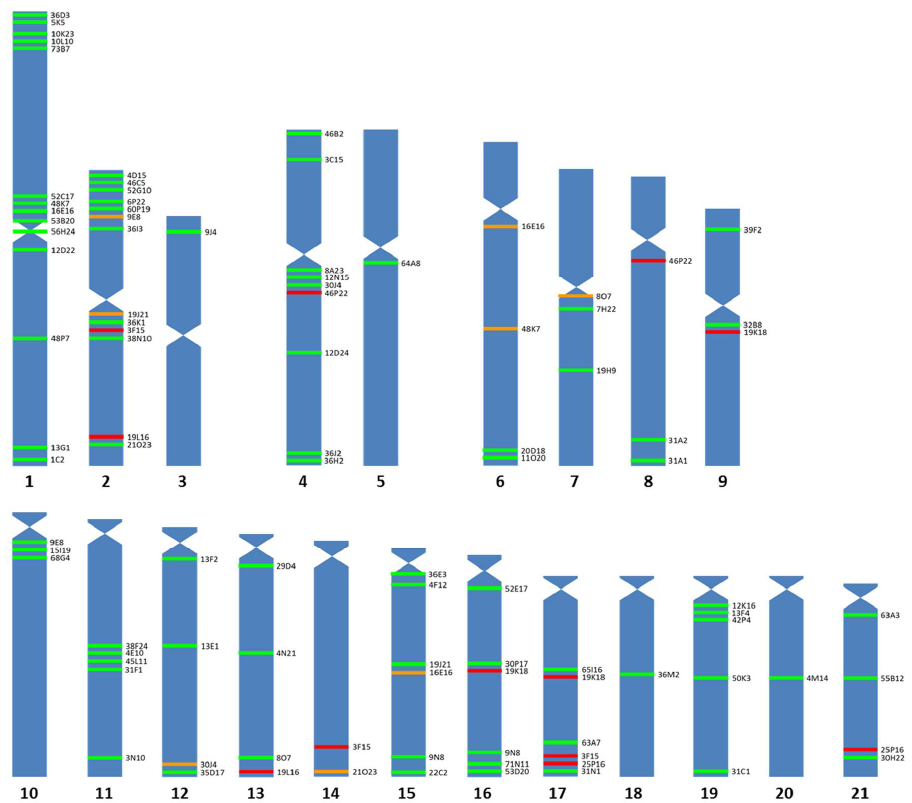
Figure 1. Idiogram of Solea senegalensis showing positive signals of 83 BAC probes. Seventy-eight of them were assigned to specific chromosomes (green lines) and five showed multiple signals that cannot be assigned to a specific chromosome (red lines). Orange lines represent the secondary signals of the specifically located BAC probes.